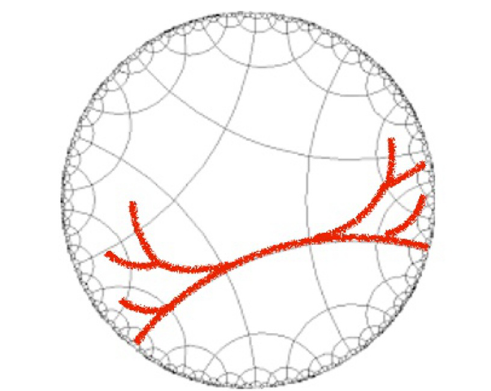
Figure 4 . A tree-wall in I 5 , 3 and its intersection with an apartment. The tree-wall coincides with a geodesic in the HaPPY apartment, but at every tile, it divides into two branches due to the link structure of I 5 , 3 . In the end, we end up with a homogeneous trivalent